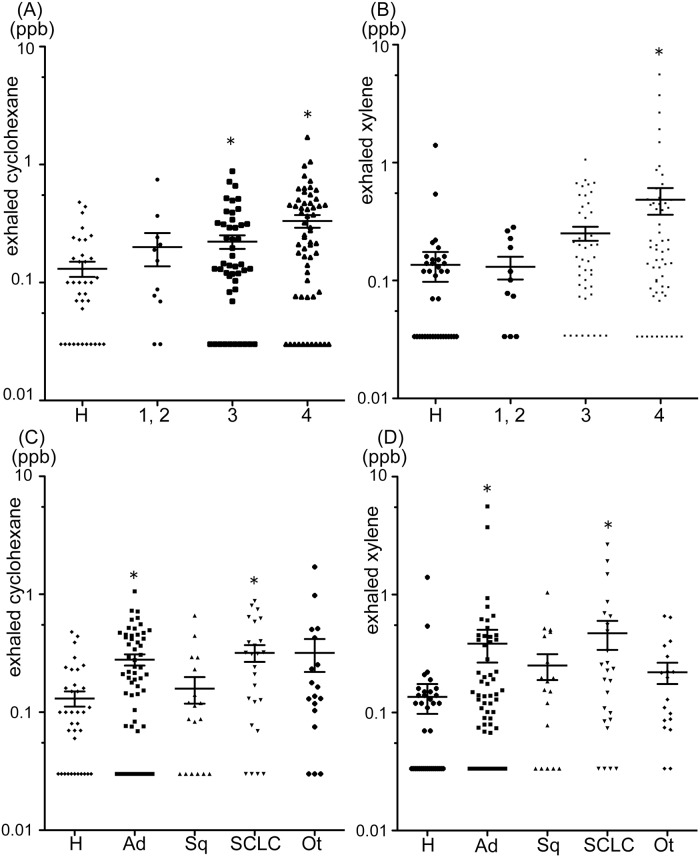
Relationships between exhaled cyclohexane (A) and xylene (B) and clinical stages of lung cancer and between exhaled cyclohexane (C) and xylene (D) and pathological types of lung cancer.The horizontal lines indicate the median values. *p < 0.05, compared with healthy subjects by Kruskal-Wallis test. H = healthy subjects; 1,2 = clinical stage 1 or 2; 3 = clinical stage 3; 4 = clinical stage 4; Ad = adenocarcinoma; Sq = squamous cell carcinoma; SCLC = small cell carcinoma; Ot = others, including large cell neuroendocrine carcinoma and NSCLC not otherwise specified.